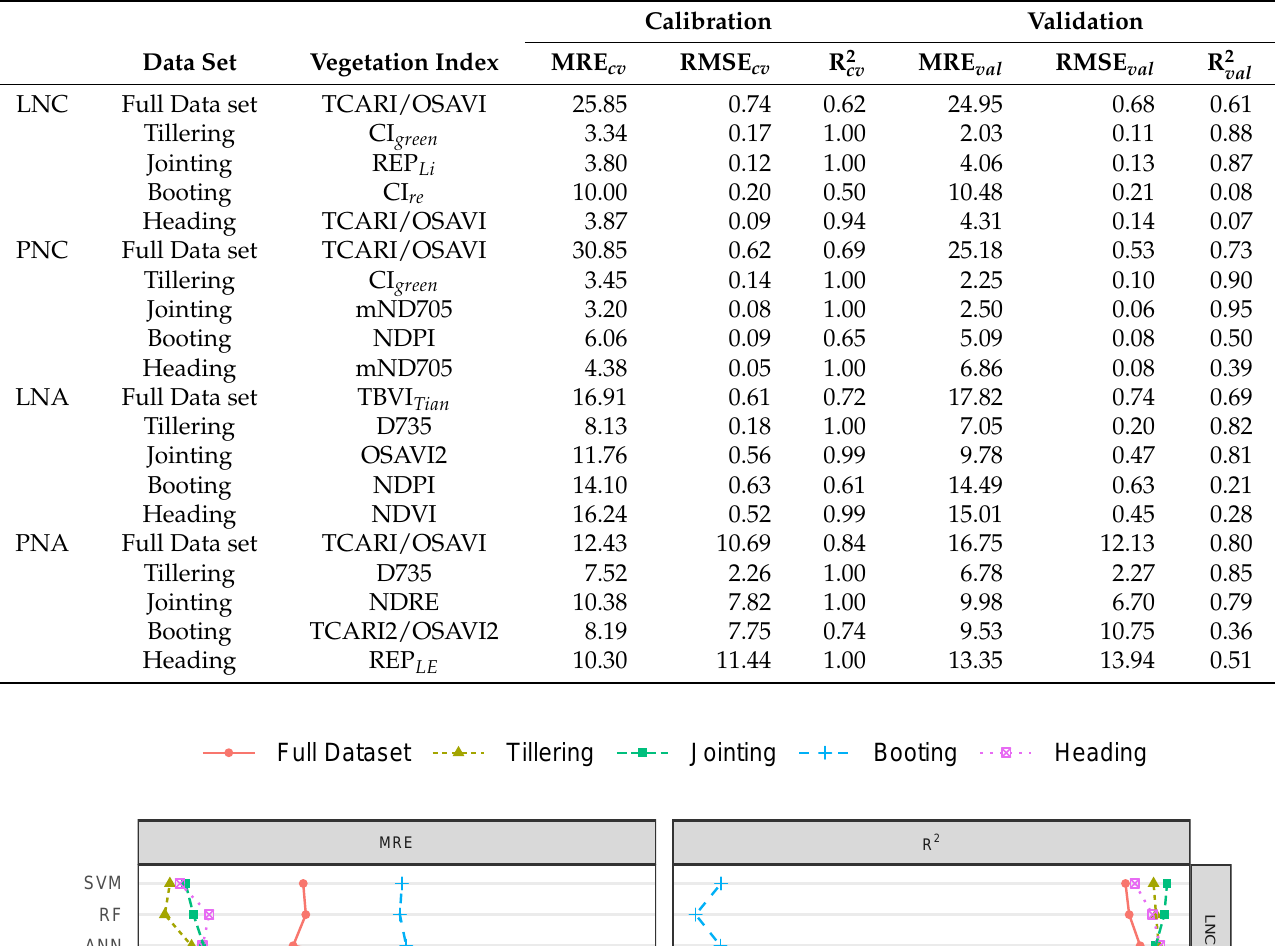
Table 3. The goodness-of-fit of the best-performing VIs of the full-growth-stage and growth-stage-specific models for LNC, PNC, LNA and PNA selected according to MRE cv .